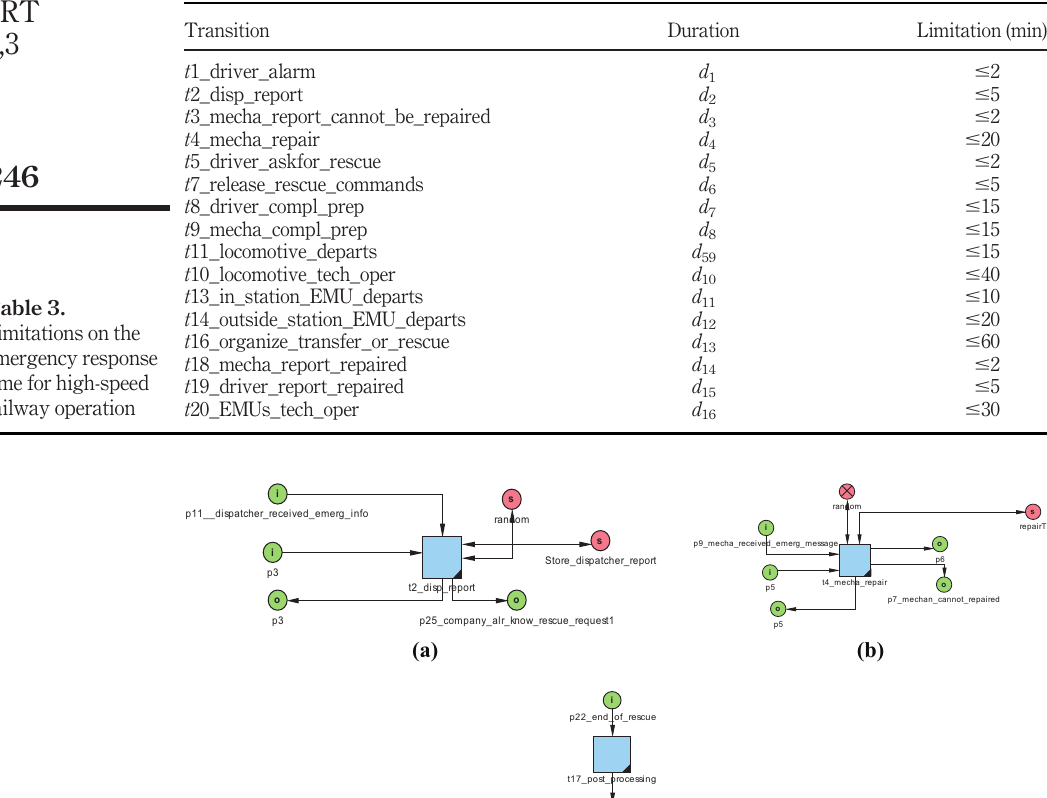
Figure 8. Simpli fi ed sub-nets of EMUs rescue emergency